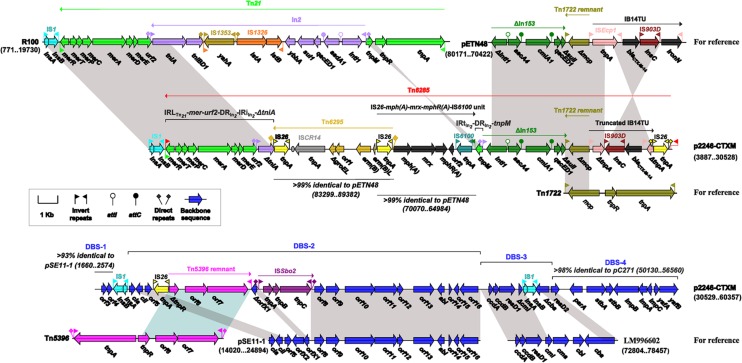
The mosaic region of p2246-CTXM with comparison to similar elements. Genes are denoted by arrows and colored based on gene function classification. Shading regions denote shared DNA regions of homology (>95% nucleotide similarity).